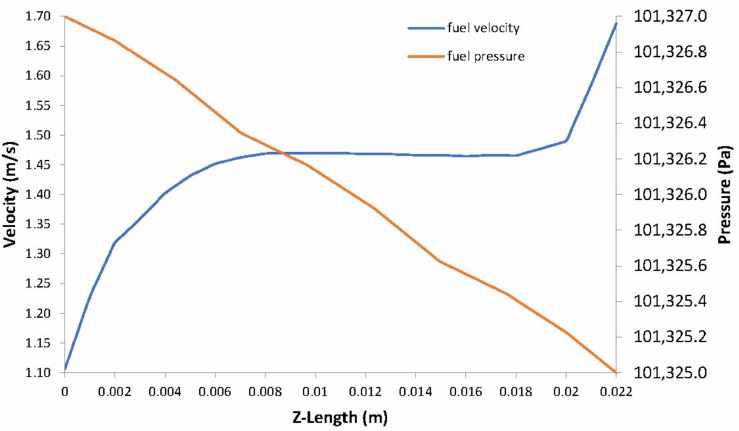
Figure 8. Fuel velocity vs. fuel